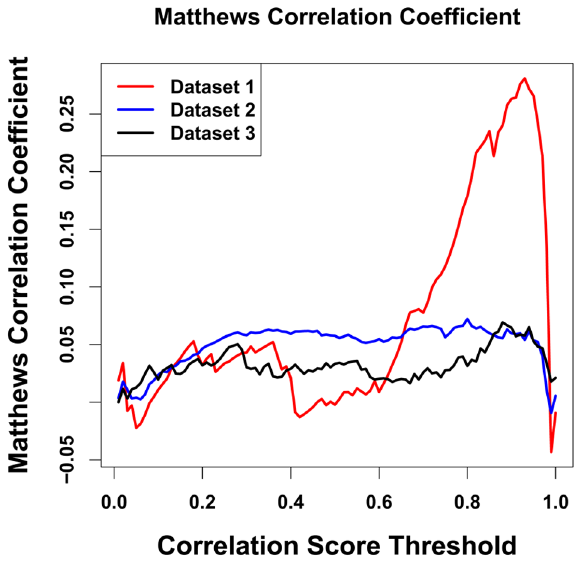
Figure 5. Plot of sensitivity, specificity, and MCC vs. threshold for binary classification using Dataset 1. It is seen that the peak of the MCC (dashed vertical line) occurs in this case where the specificity is somewhat larger than the sensitivity. A user may wish to use a threshold either larger or smaller than the position of the peak of the MCC, depending on whether specificity or sensitivity is more highly valued.